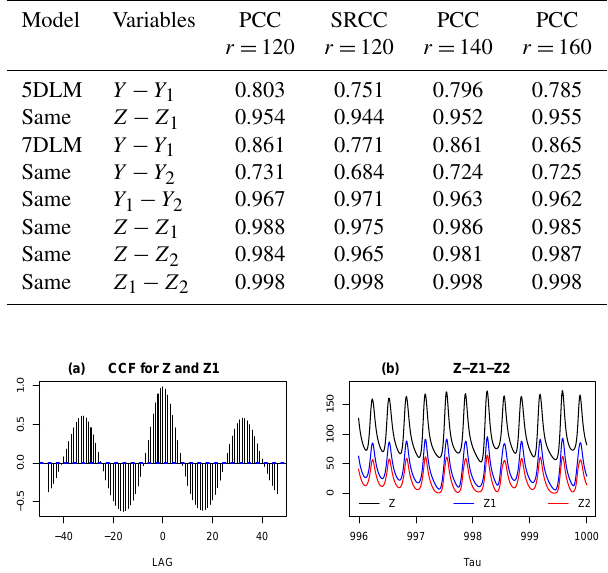
Figure 11. The cross-correlation function (CCF) for two time series ( Z and Z 1 ) (a) and the time evolution of Z , Z 1 , and Z 2 (b) from the 7DLM with r = 120. The total integration time is τ =